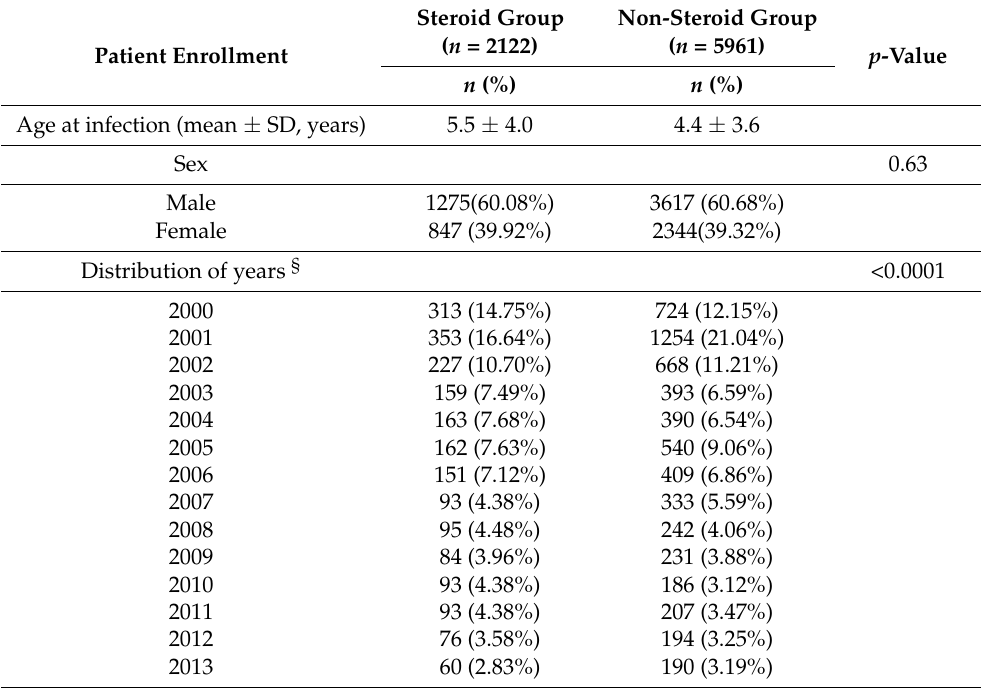
Table 1. Baseline characteristics of patients.